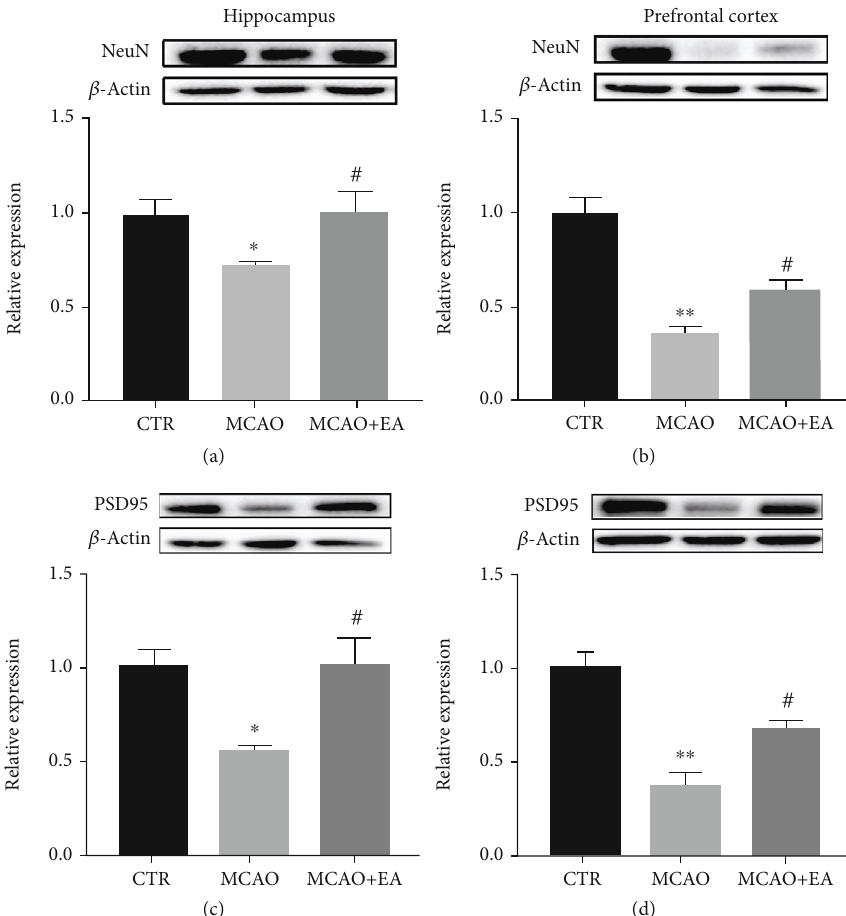
Figure 8: E ff ects of the MCAO and EA in synaptic-related proteins. E ff ects of MCAO and EA on the expression of the neuroplasticity biomarkers, NeuN (a, b) and PSD-95 (c, d) in the hippocampus and PFC. Value is expressed as mean ± SEM , where ∗ p < 0 : 05 and ∗∗ p < 0 : 01 compared to the control group and # p < 0 : 05 and ## p < 0 : 01 compared to the MCAO group ( n ≥ 5 each group). CTR: control; MCAO: middle cerebral artery occlusion; EA: